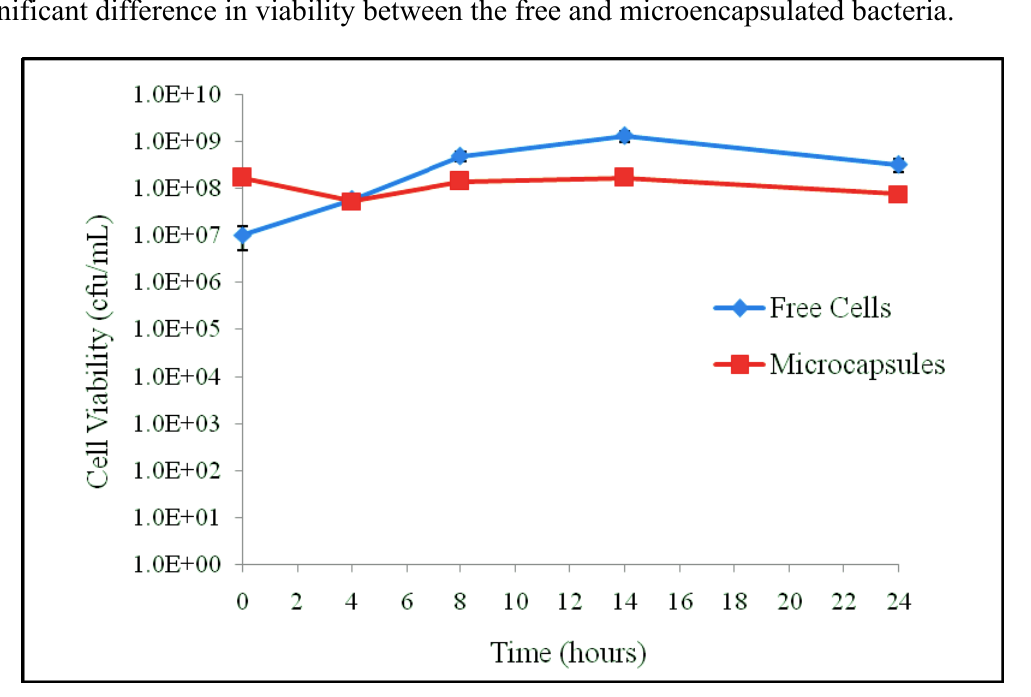
Figure 3 . The viability of the free and microencapsulated L. fermentum NCIMB 5221 during the FAE assay (MRS-EFA 0.2956 mg/mL at 37 °C). Each point represents the mean of triplicates and the error bars the standard deviation. During the assay, there was no significant difference in viability between the free and microencapsulated